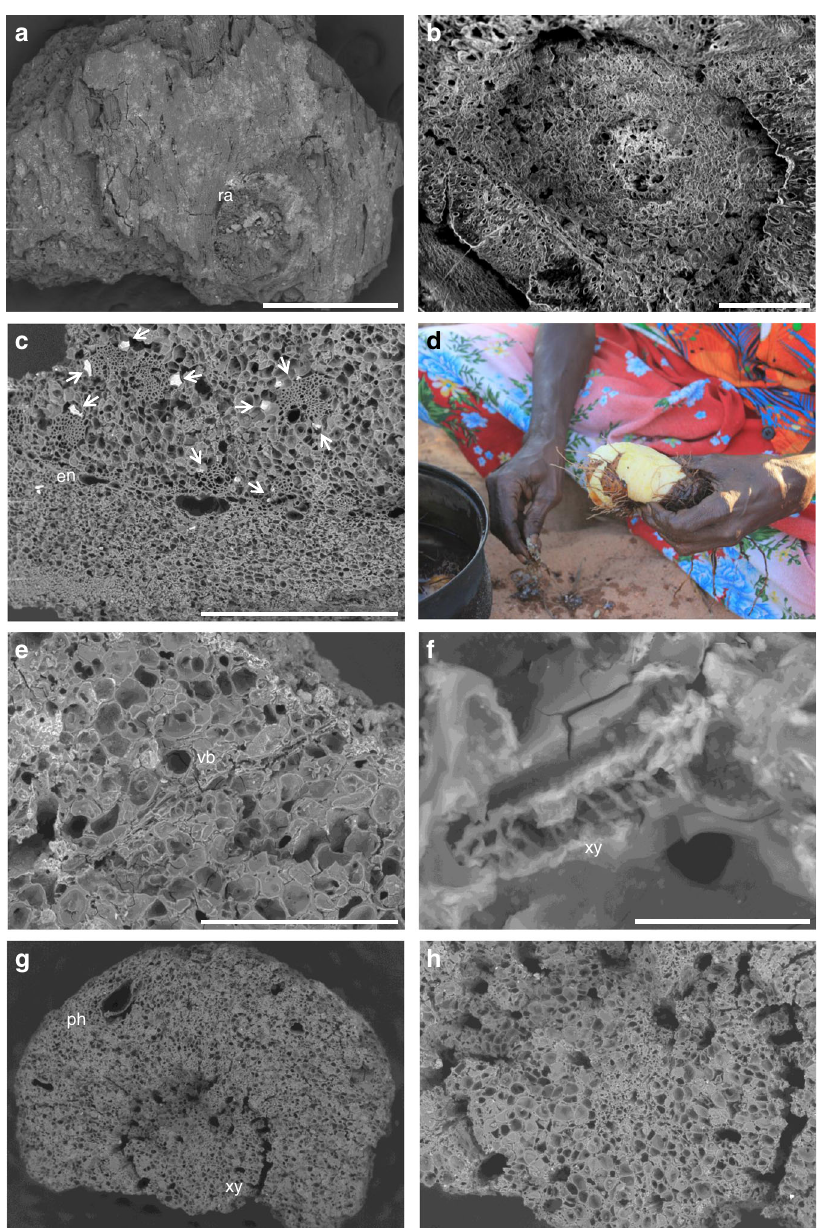
Fig. 3 Examples of vegetative parenchyma from Phase 2. a , b Monocotyledonous stem-based storage organ Type A from C2/41; a depicting skin- patterning and root abscission scar, scale bar is 500 µ m; b close-up of root abscission scar, scale bar is 100 µ m; c transverse section of monocotyledonous stem-based storage organ Type A from C2/32 A, depicting an endodermis and a series of closed collateral vascular bundles, arrows point to phytoliths on edges of vascular bundles, scale bar is 500 µ m; d MN peeling a ‘ hairy ’ Dioscorea bulbifera tuber beside a hearth built to cook it, photo taken by SAF; e , f longitudinal section of monocotyledonous stem-based storage organ Type B; e scale bar is 300 µ m; f close-up of vascular bundle, scale bar is 20 µ m; g , h transverse section of secondary-root storage organ Type A from C2/39 A; g scale bar is 2 mm; h close-up of central tract of xylem, scale bar